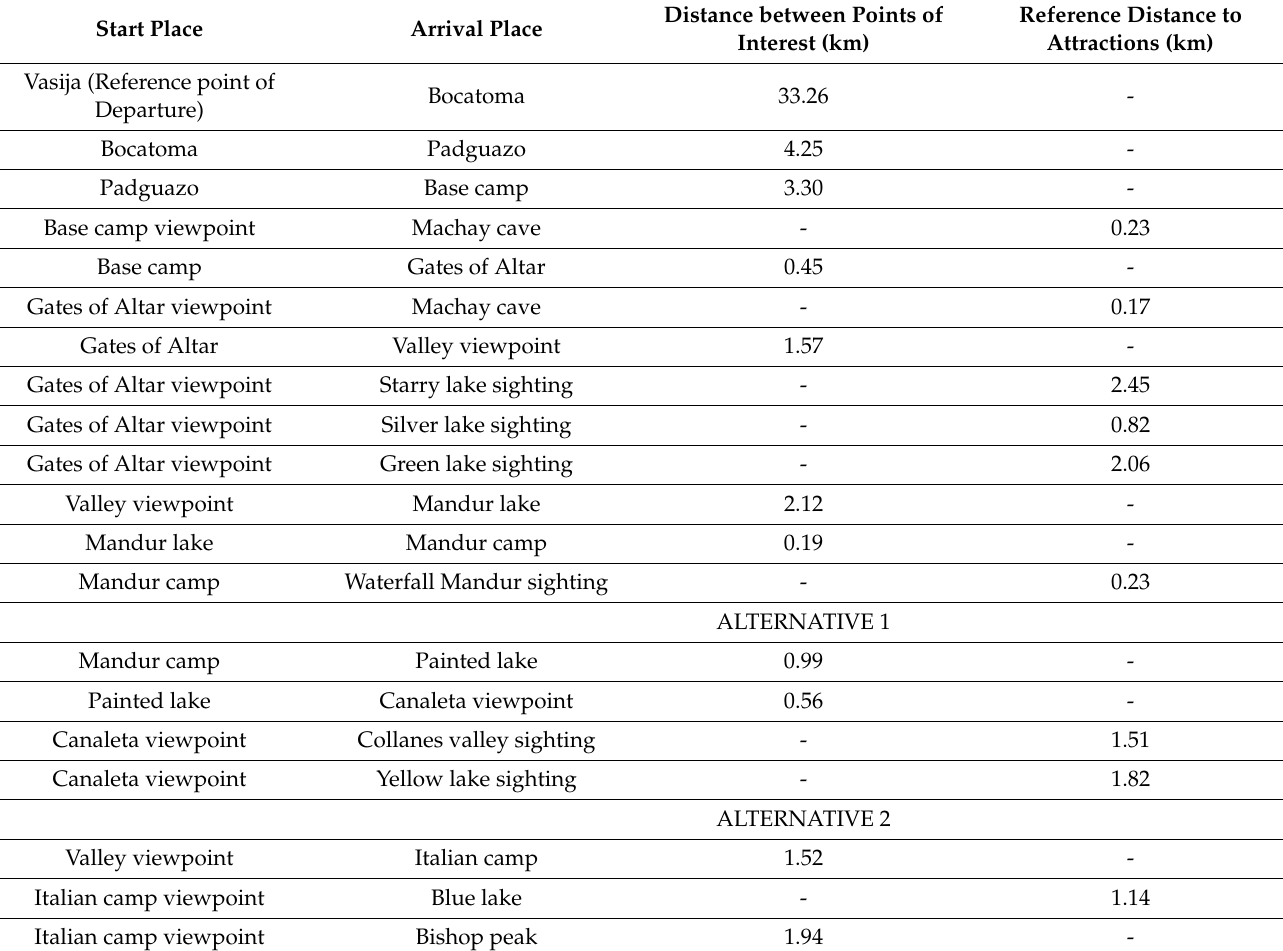
Table 3. General description of distances routes in